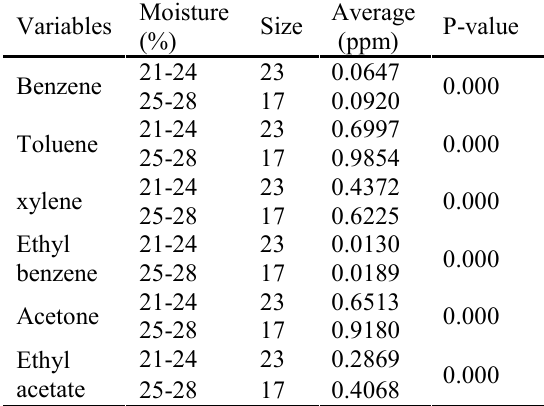
Table 8. Effect of moisture during measurement on the concentration of volatile organic